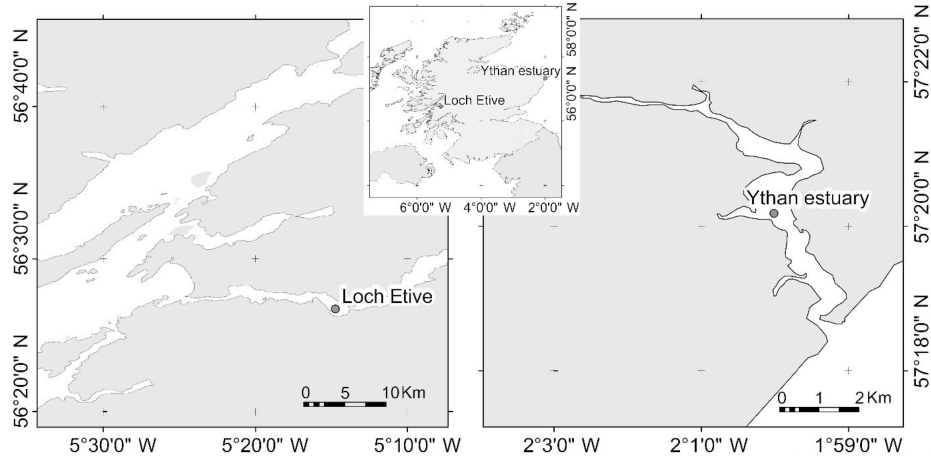
Figure 1. Map showing site